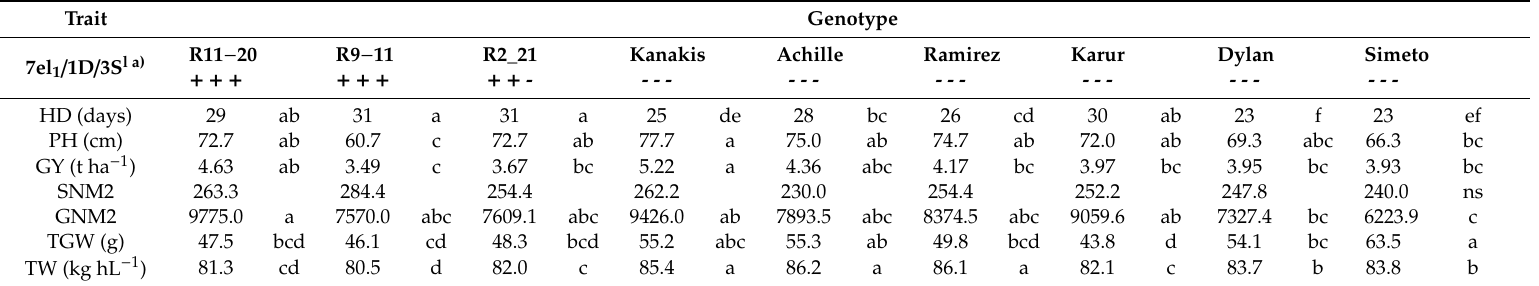
Table 5. Mean values of yield related traits recorded in 2017